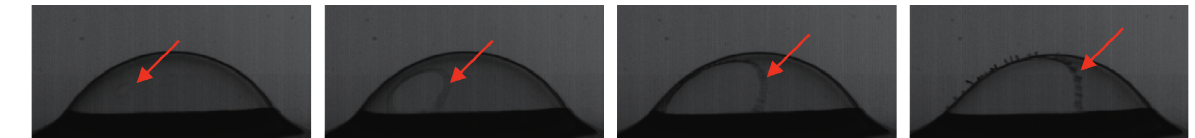
Figure 3: Visualized image of bubble cap film